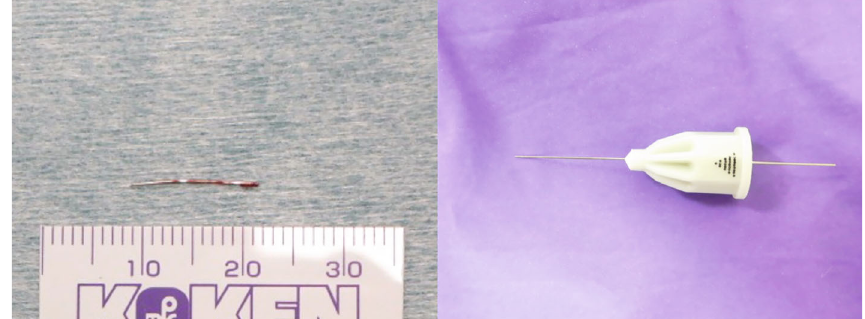
Figure 4: The removed disposable dental injection needle and unused disposable dental